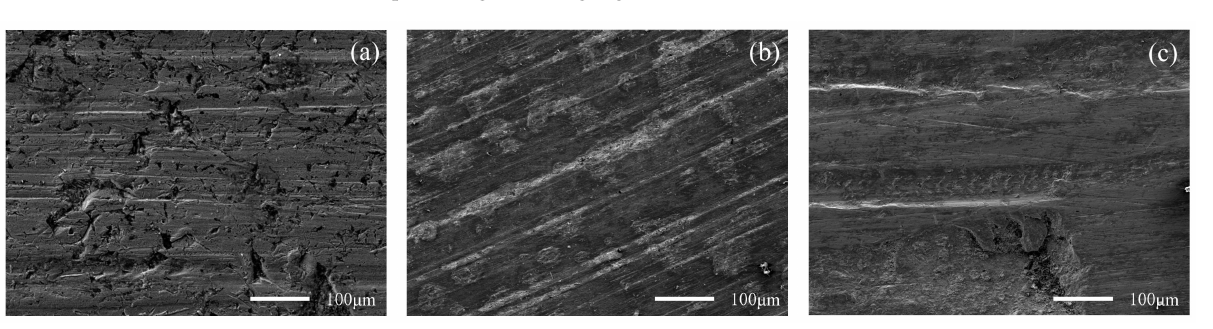
Figure 12. SEM morphology of worn surfaces of ZM4-13 with varying pH values of simulated mine water at the percentage of coal gangue of 50%: 3.5 ( a ), 7 ( b ), 11.5 ( c ).